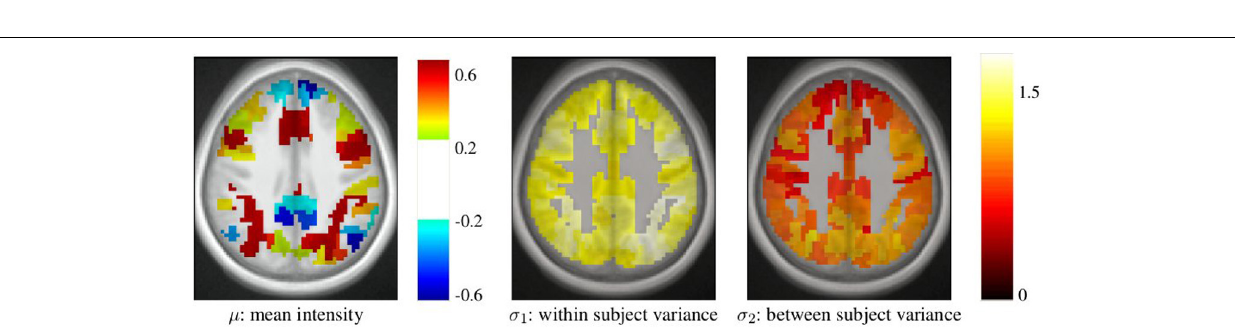
These parameters are those for the computation-sentence reading functional contrast. μ : mean intensity, σ 1 : within subject variance, and σ 2 : between subject